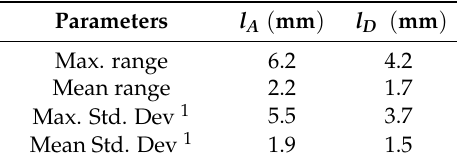
Table 8. Range of the measuring.